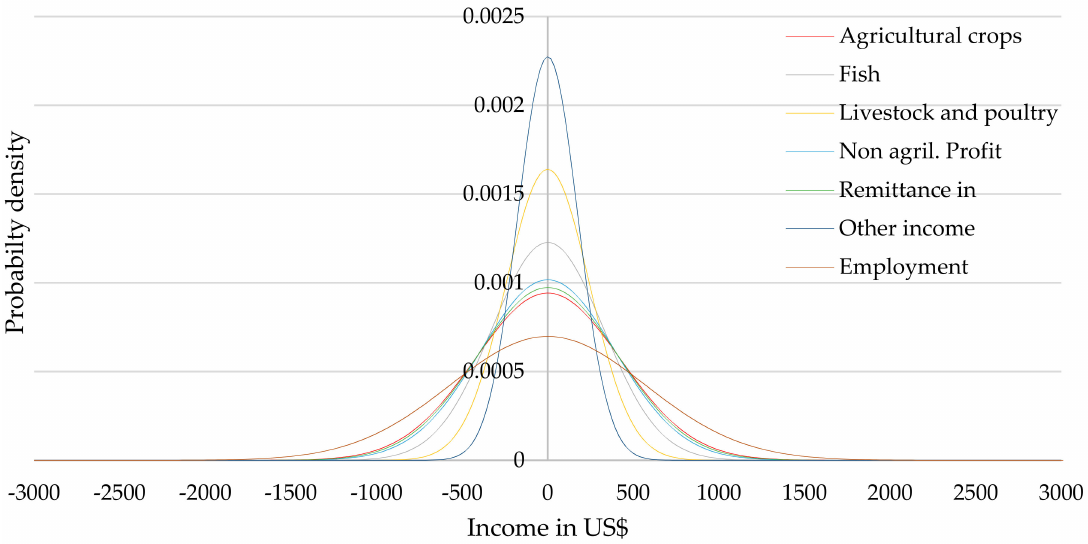
Figure 5. Distribution of total income (US$) for farm households in Mymensingh by income